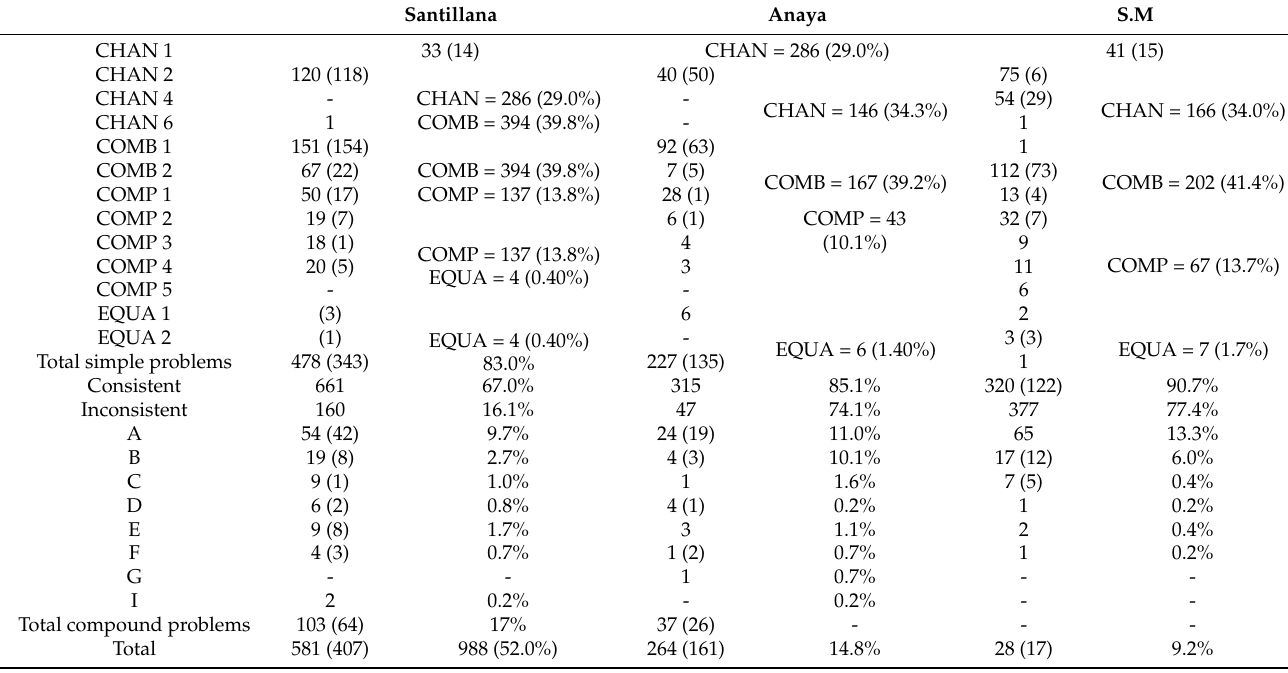
Table 4. Results of the frequency and variability of the problems by